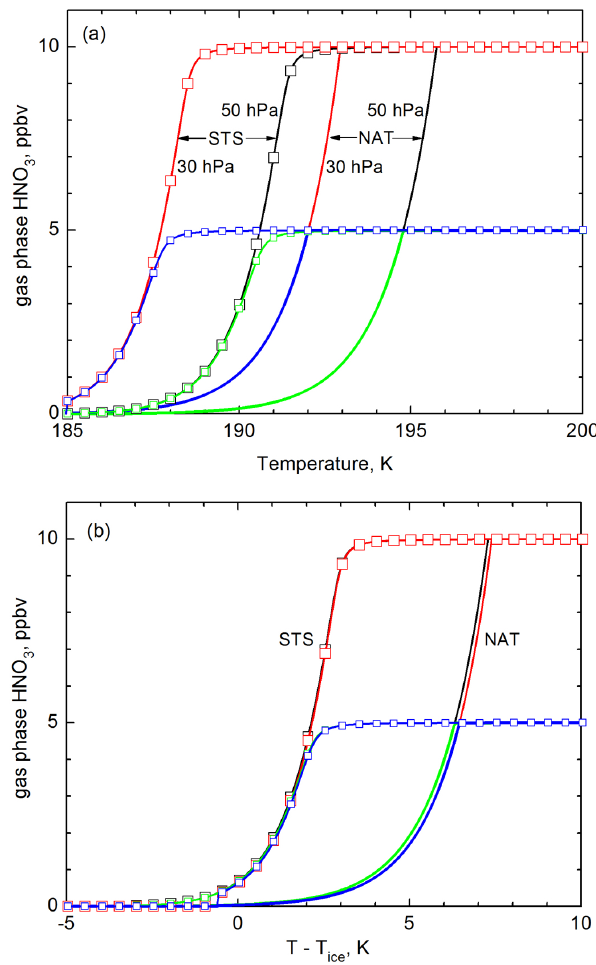
Fig. 2. Theoretical equilibrium uptake of HNO 3 by STS (square symbols) and NAT as a function of (a) temperature and (b) T − T ice . Red and black curves/symbols: 10ppbv HNO 3 , 5ppmv H 2 O; blue and green curves/symbols: 5ppbv HNO 3 , 5ppmv H 2